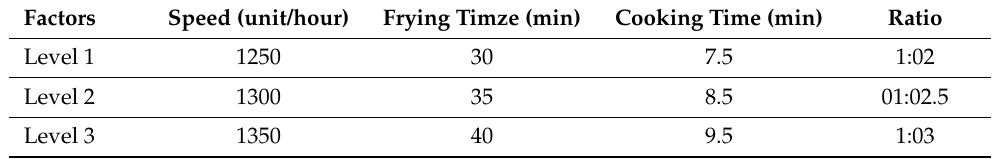
Table 7. Levels for the controllable factors.